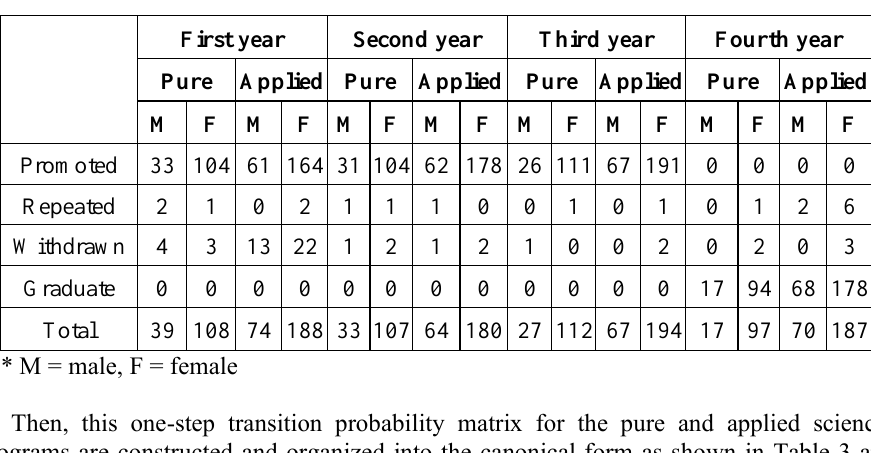
Table 3. The initial transition probability matrix